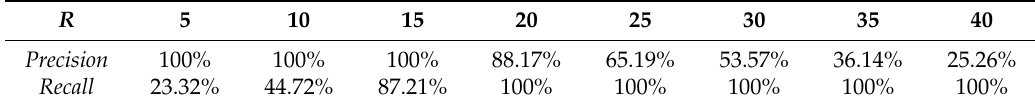
Table 2. Real-time processing balance factor R